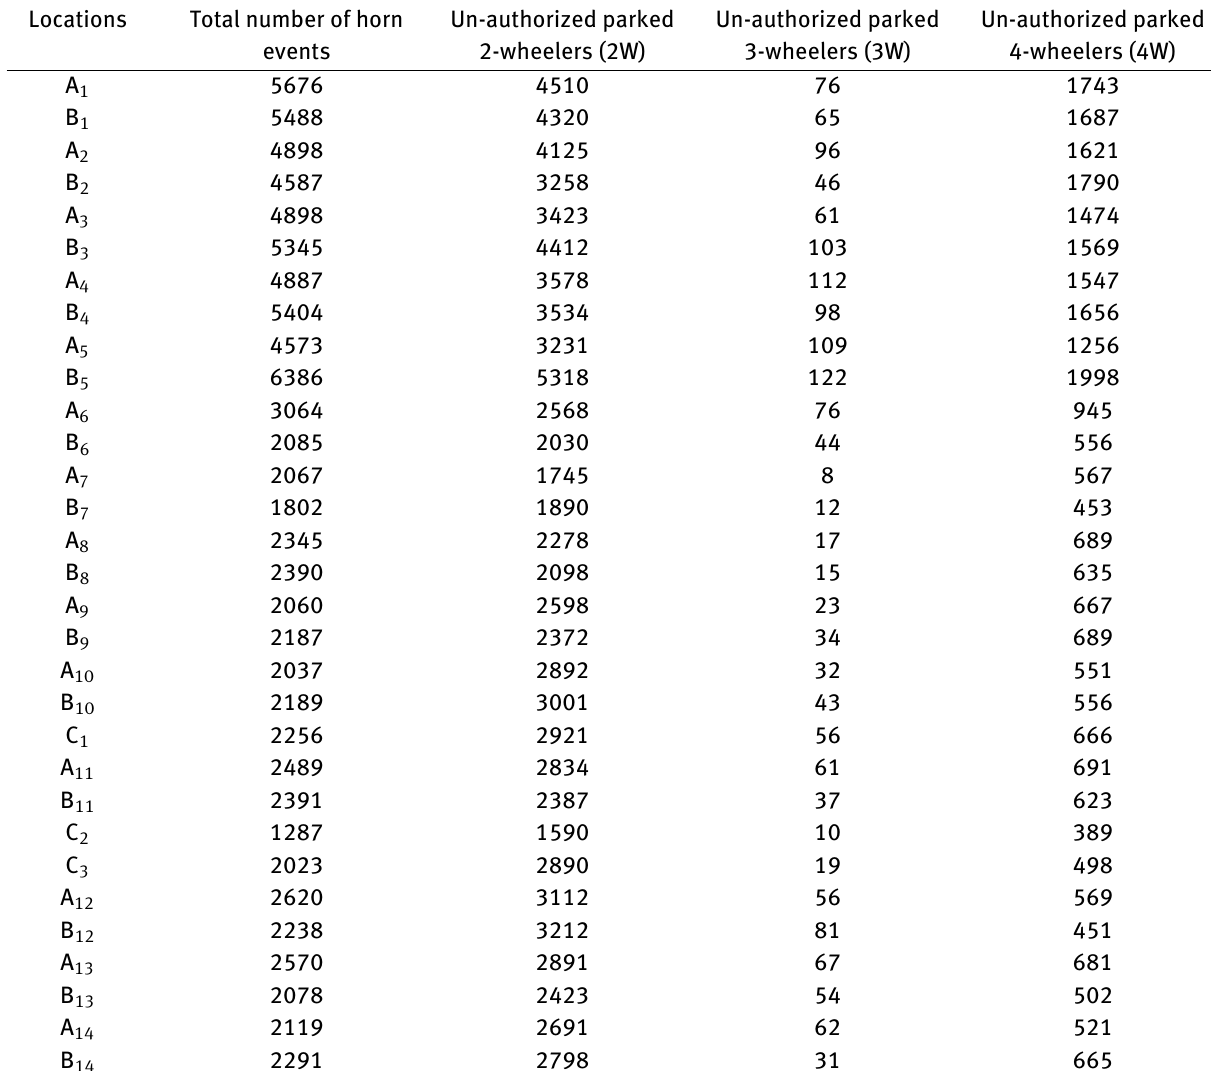
Table 3: Number of horn and un-authorized parked vehicles of South-West zone of Surat city